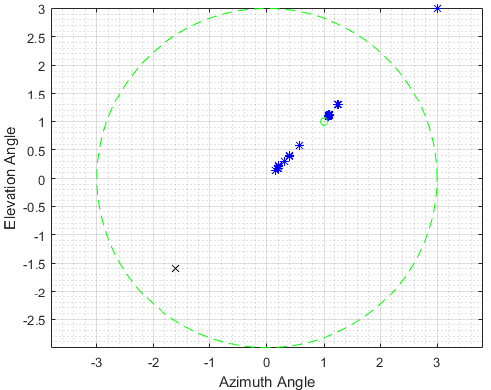
Figure 3. The estimated angle of two unresolved targets by typical monopulse radar (the green circle is 3 dB width of the sum beam; truth locations: decoy ( O ), real target ( x ), and estimated angle (*) ). The accuracy of the proposed angle estimation method is shown in Figure 4 for SNR = 20 dB and SNR = 30 dB (20 times).